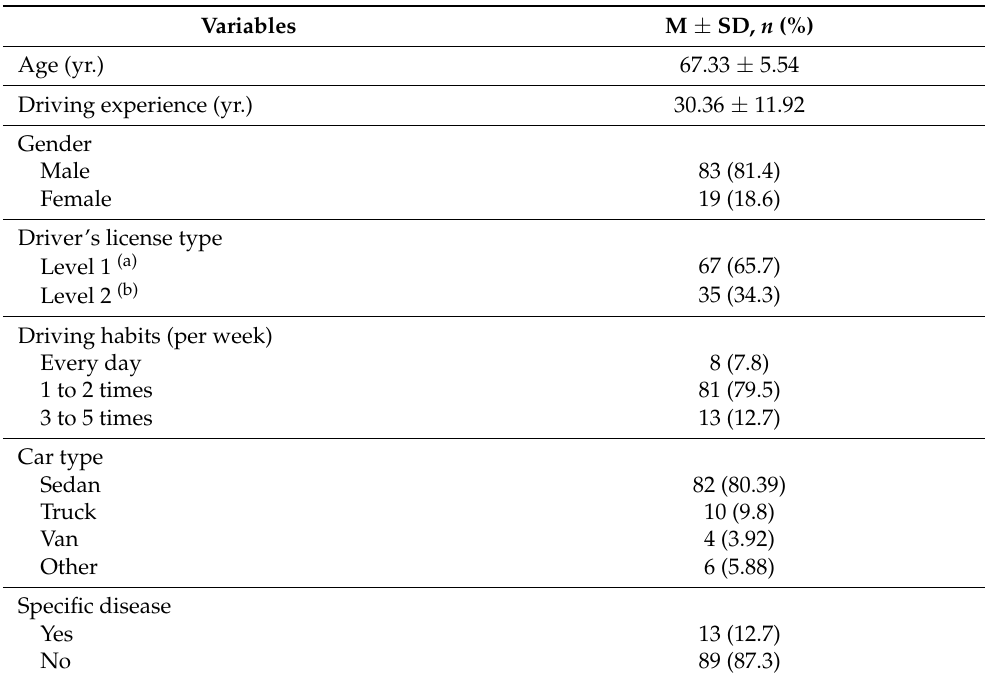
Table 1. General characteristics of participants ( n = 102).